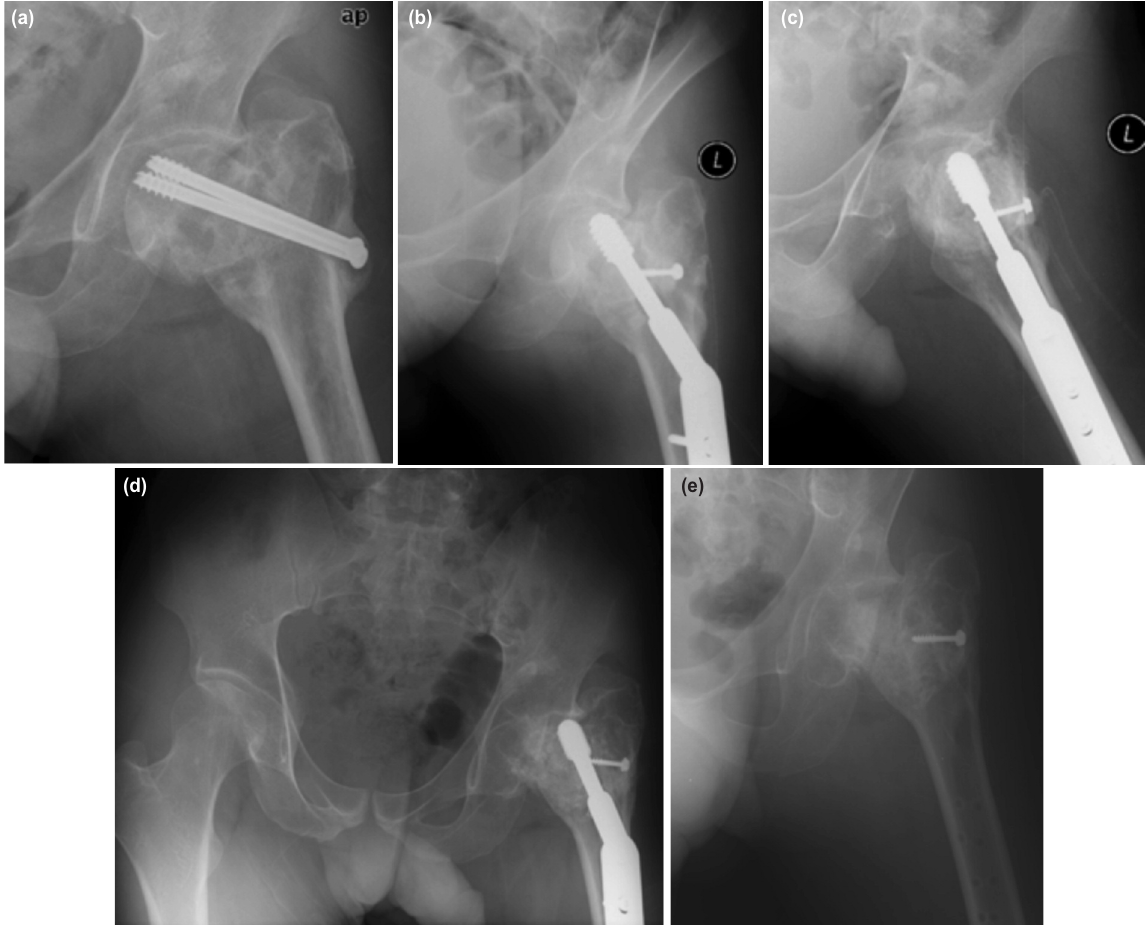
(a) Photos showing the case no. 5 with non-union of the femoral neck, loosening of the screws, resorption of neck and AVN of Fig. 2: the femoral head evidenced by sclerosis of the entire head, (b, c) after removal of the previous implants, dynamic hip screw and anti-rotational screw were inserted, and myo-osseous trochanteric flap was performed leading to successful union, (d) however the AVN progressed with collapse of the femoral head five years later, (e) warranting an early implant removal. The patient was ambulating with Trendelenburg gait and required single crutch in daily activity. He was planned for an early joint replacement